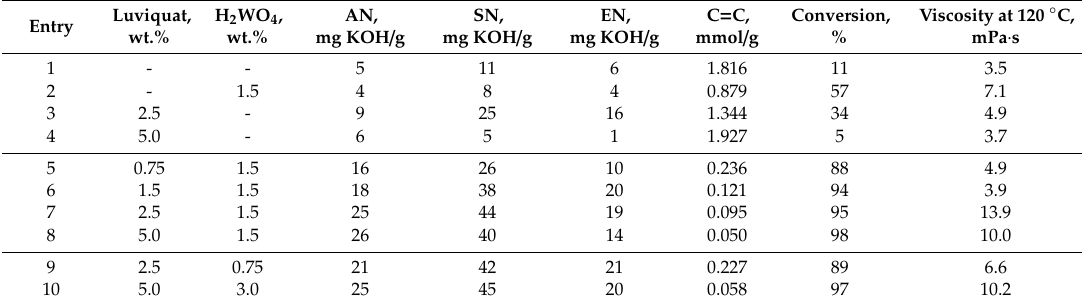
Table 2. E ff ect of H 2 WO 4 and Luviquat on the C30 + olefins oxidation using H 2 O 2 .